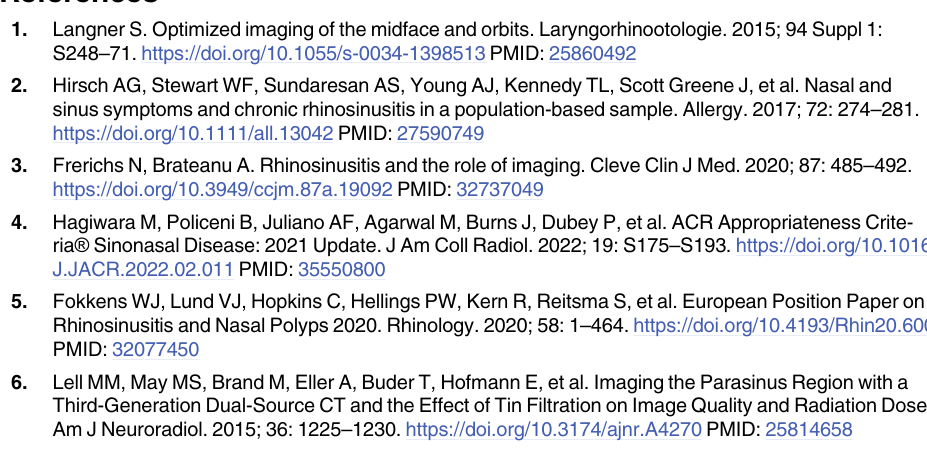
interes, Std.Dev. = standard deviation, Sn = tin filter. S3 Table. Number of raters per protocol and Likert score in subjective image assessment for sinusitis diagnosis and preoperative planning. Protocols are color coded based on their